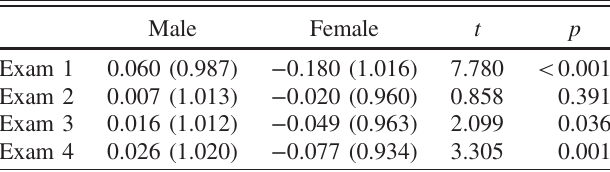
TABLE V. Average exam z scores (and standard deviation) for algebra-based mechanics, as well as the t test and significance between these distributions.